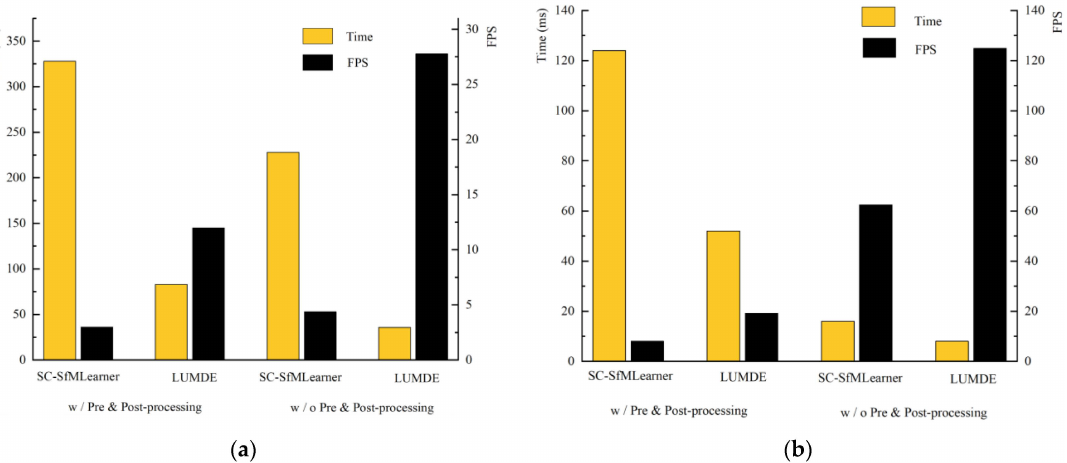
Figure 4. ( a ) Inference efficiency on an i5 core CPU; ( b ) Inference efficiency on an Nvidia